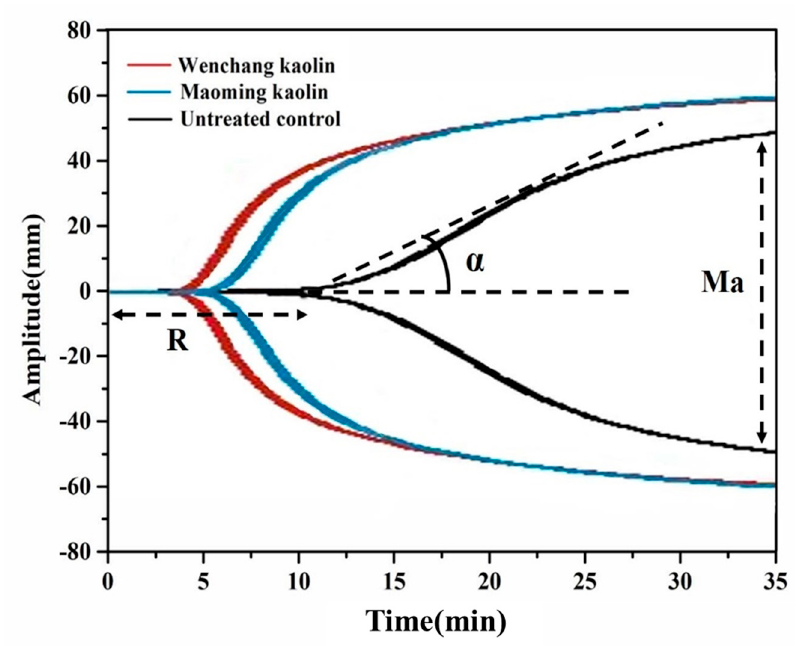
Figure 6. TEG showing the clotting characteristics of the Wenchang kaolin sample, Maoming kaolin sample, and untreated control in whole blood of beagle dogs.